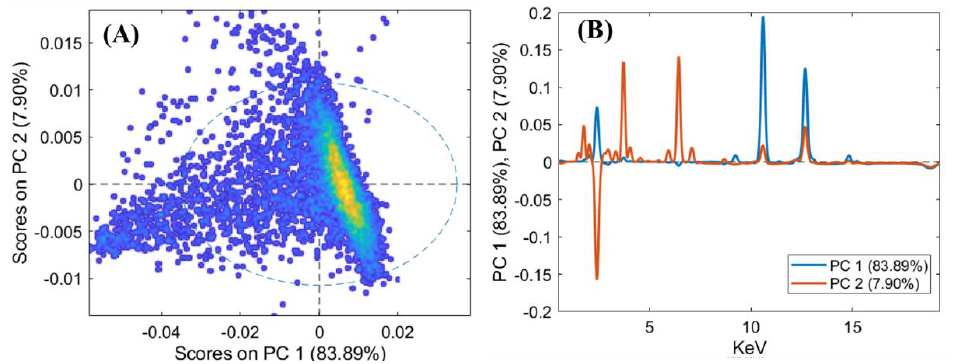
Figure 9. Principal component analysis (PCA) score plot of the XRF spectra ( A ) and the loadings of PC1 and PC2 ( B ) for the three lead wheels (i.e., ornamental jewellery, talismans, or little toys).